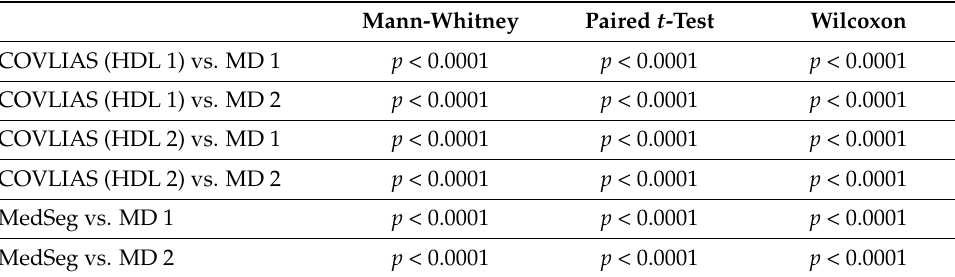
Table 2. Mann–Whitney, Paired t -test, and Wilcoxon test for COVLIAS and MedSeg for combined lung area against